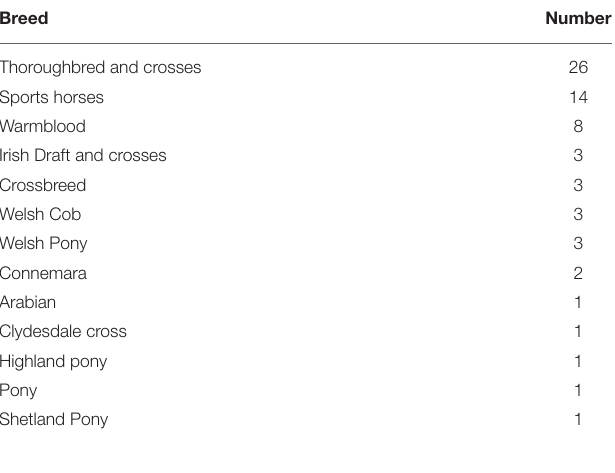
TABLE 1 | Breed distribution in the study population. Breed Number